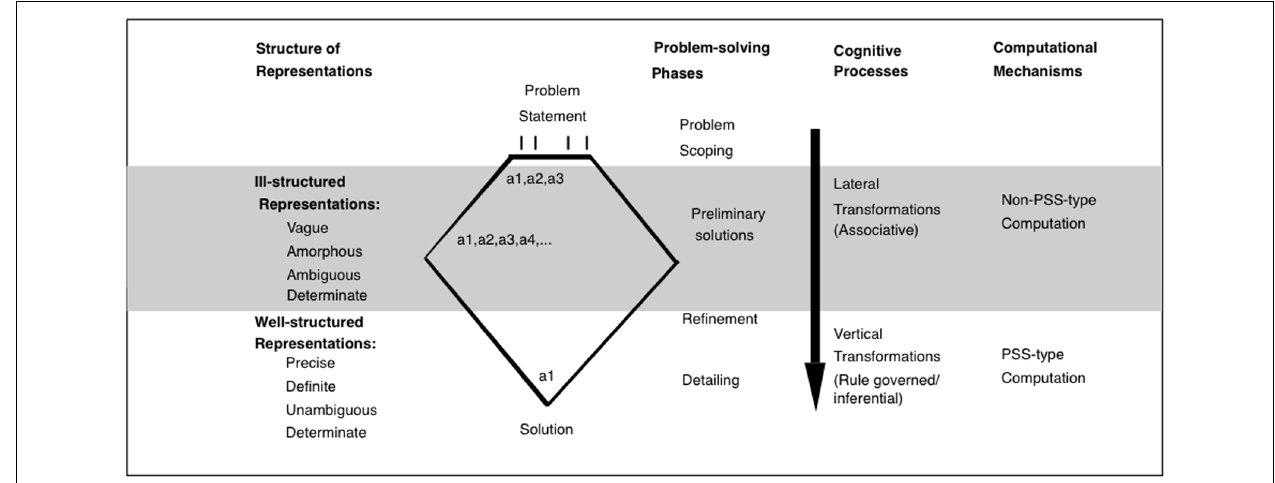
FIGURE 4 |Aspects of design problem solving. Unlike the state space for well-structured problems, the state space for ill-structured, real-world problems must support different problem-solving phases, which need to be supported by different representational systems, cognitive processes, and computational mechanisms. PSS-type and non-PSS-type indicate physical